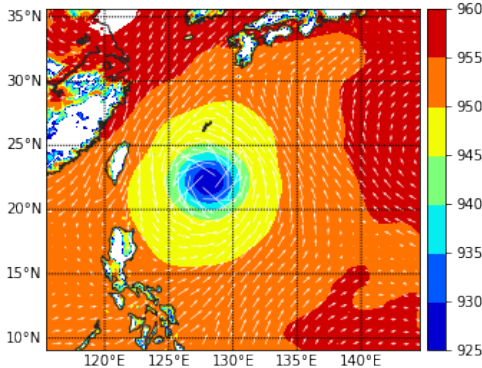
Figure 8. Weather situation on 1800 UTC 26 September